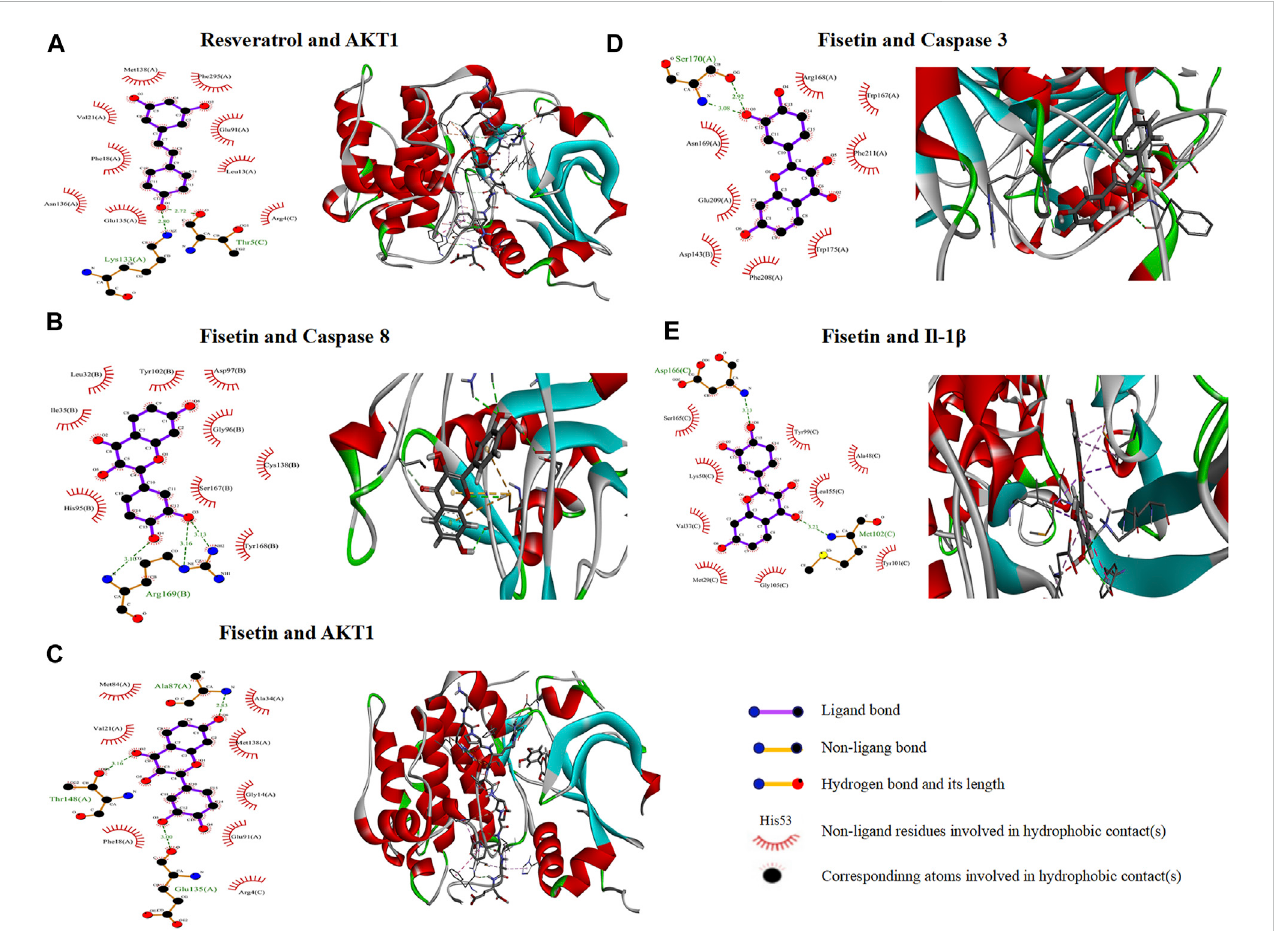
FIGURE 5 2Dand3Dinteraction mappingofmoleculardocking. (A) Resveratroldockedwith AKT1 . (B) Fisetin dockedwith CASP8 . (C) Fisetin dockedwith AKT1 . (D) Fisetin docked with CASP3 . (E) Fisetin docked with IL-1 β